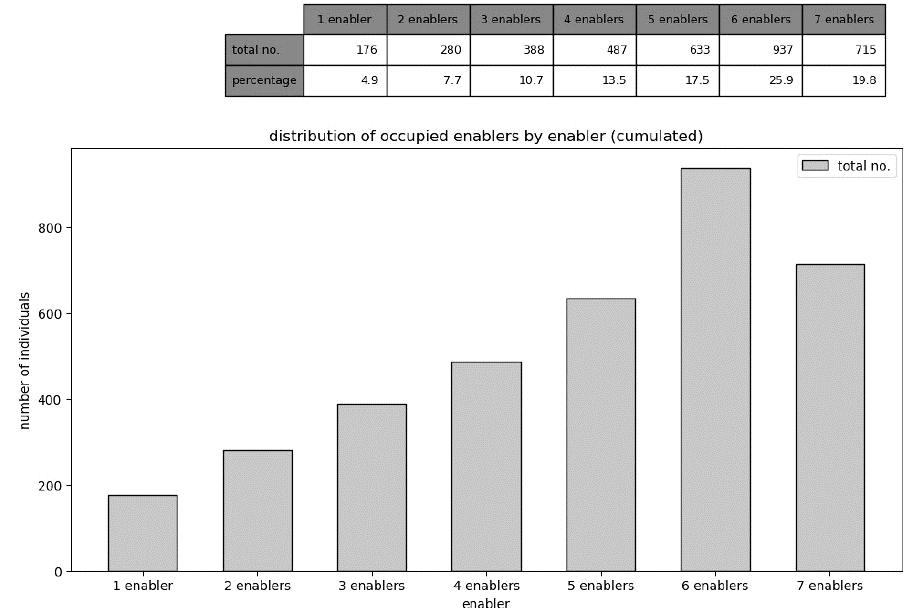
Figure 10. Distribution of occupied bins (enabler) by enabler